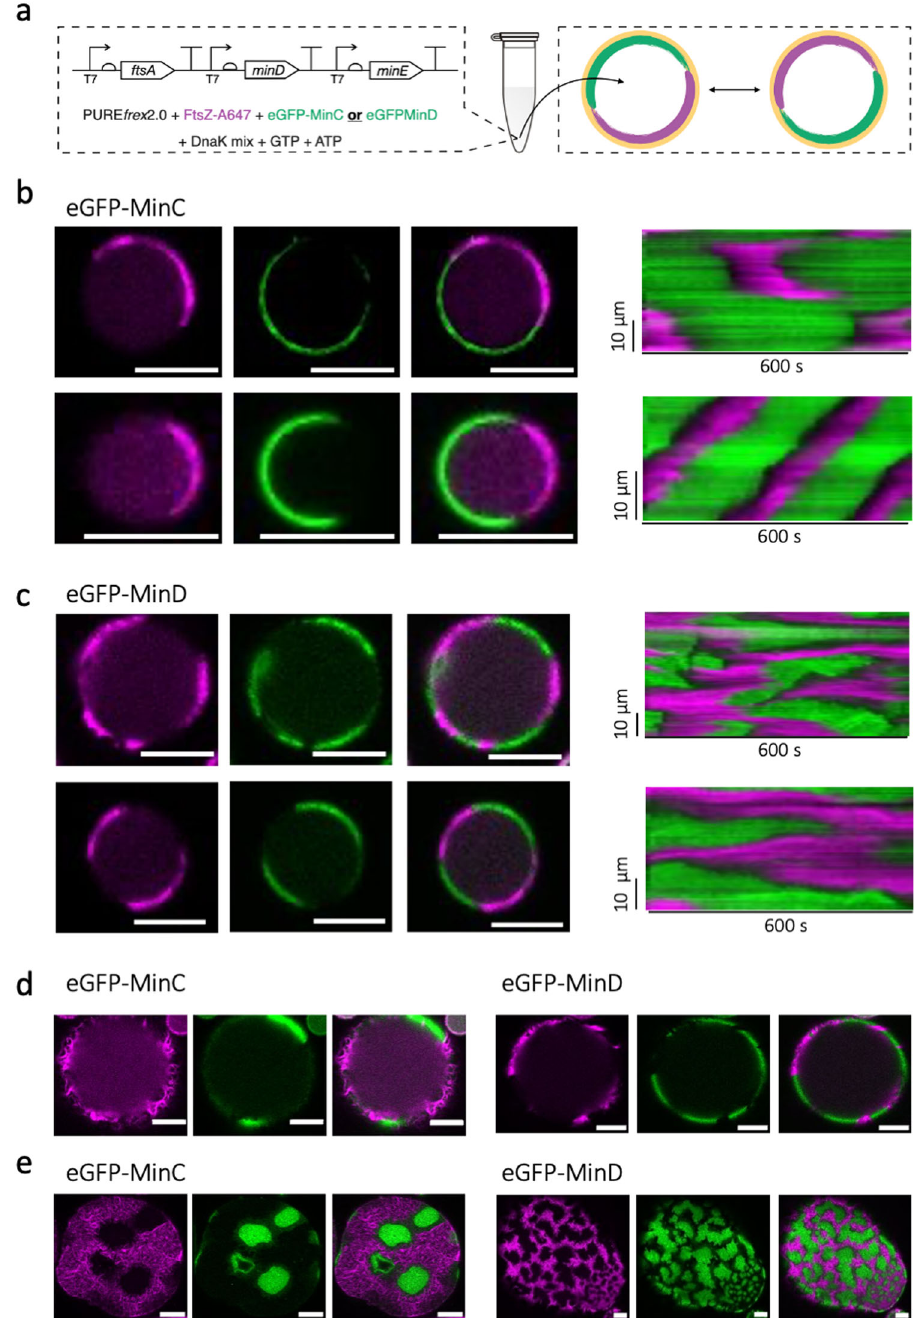
Fig. 4 Functional reconstitution of MinDE(C) and FtsA-FtsZ networks in microdroplets. a Schematic illustration of the droplet assays. The DNA template containing the genes ftsA , minD , and minE (5 nM) was expressed in a test tube in the presence of DnaK mix. The pre-ran PURE frex 2.0 solution was encapsulated inside water-in-oil droplets, along with ATP (2.5 mM), GTP (2 mM), FtsZ-A647 (3 μ M) and either puri fi ed eGFP-MinC (0.5 µ M) or eGFP- MinD (100 nM). b Fluorescence images (split channels and composite) of two droplets exhibiting antiphase dynamic patterns of MinDEC and FtsA-FtsZ. The corresponding kymographs are displayed. The droplet at the bottom exhibited a circling pattern yielding a characteristic kymograph. c Same as in ( b ), except that eGFP-MinC was substituted with eGFP-MinD. d Same as in ( b ) and ( c ) (exact condition is as speci fi ed) except that bigger droplets (diameter > 20 µ m) were imaged. Here, more de fi ned cytoskeletal FtsZ structures were visible. e Same as in ( b – d ) (exact condition is as speci fi ed) except that the images have been acquired closer to the dome of large droplets. Here, multiple interfacial FtsZ polarization sites rearranged by the Min dynamics were visible. Color coding: eGFP-MinC and eGFP-MinD (green), FtsZ-A647 (magenta). Scale bars in all droplet images are 10 µ m.